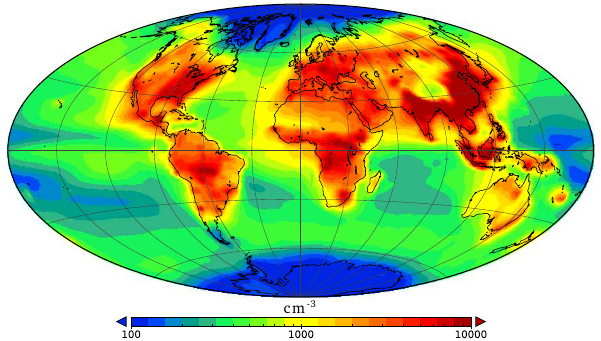
Figure 1. Annual mean surface-level aerosol number concentration (cm − 3 ) from ActNuc_BC24